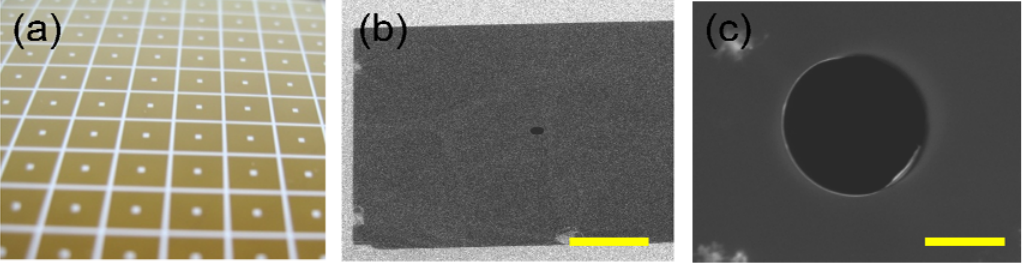
N window after completion of x y